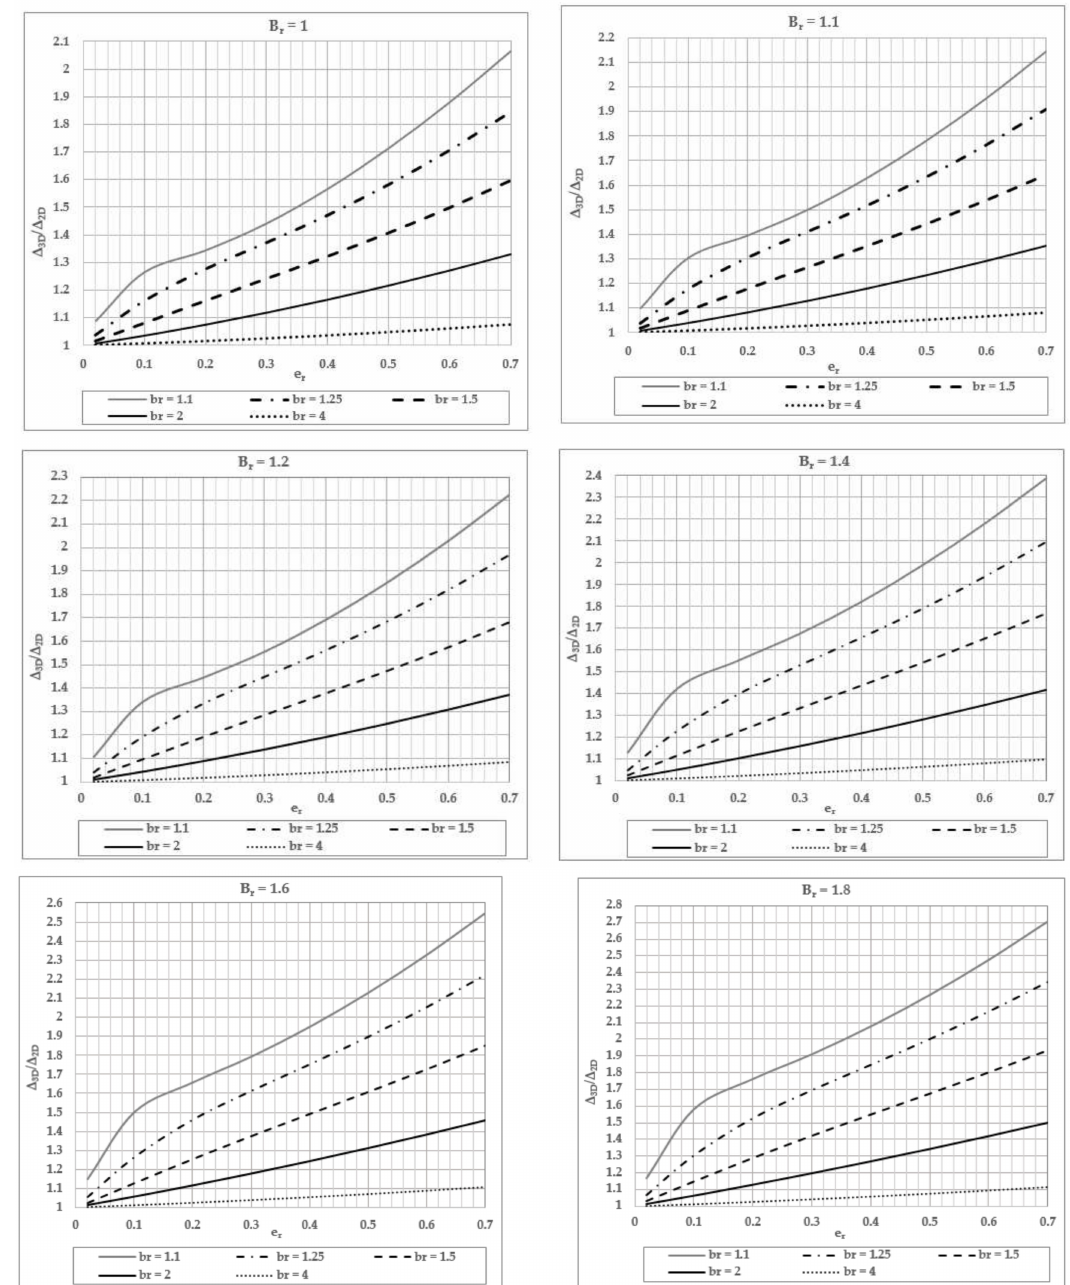
Figure 8. Edge displacement ratio for acceleration-controlled condition ( T n 1 ≤ T 1